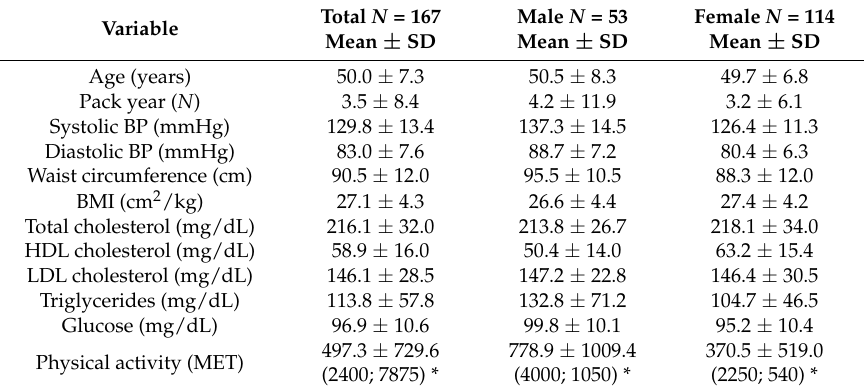
Table 1. Baseline characteristics for total sample, and by